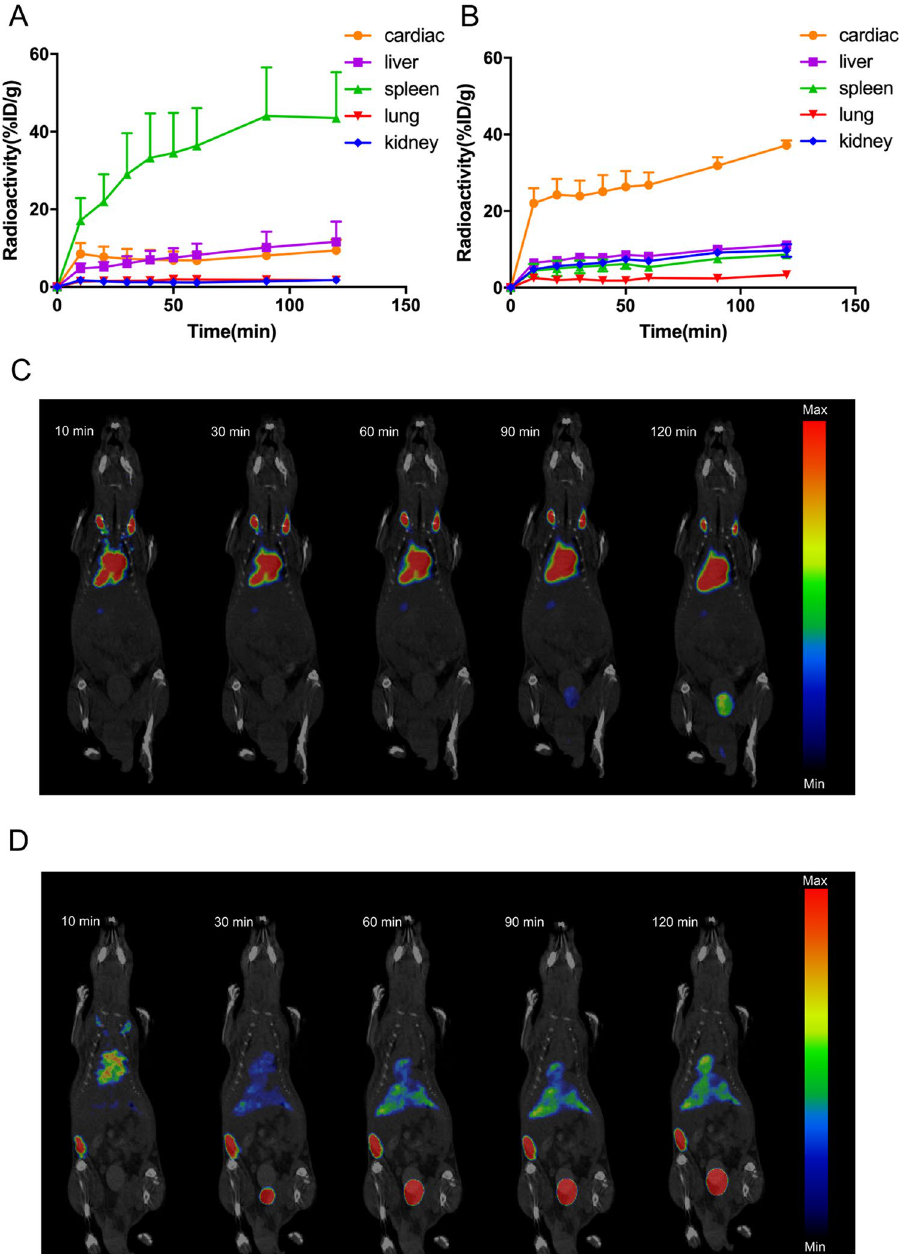
Figure 4. Stressed RBCs were trapped in spleen. ( A , B ) Time-activity curves of cardiac, liver, spleen, lung, and kidney of mice injected with 18 F-FDG-labelled untreated RBCs ( A ) and stressed RBCs ( B ) during PET/ CT imaging for 120 min (n = 3); ( C , D ) Representative serial images after intravenous injection for 120 min of 18 F-FDG-labelled untreated RBCs ( C ) and stressed RBCs ( D